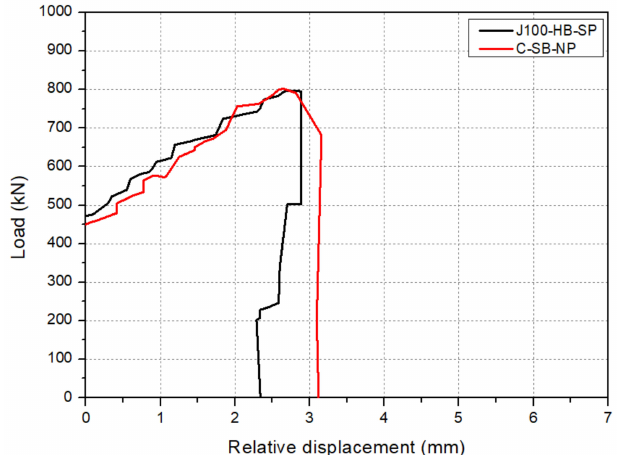
Figure 9. Load–relative displacement relationships according to the construction